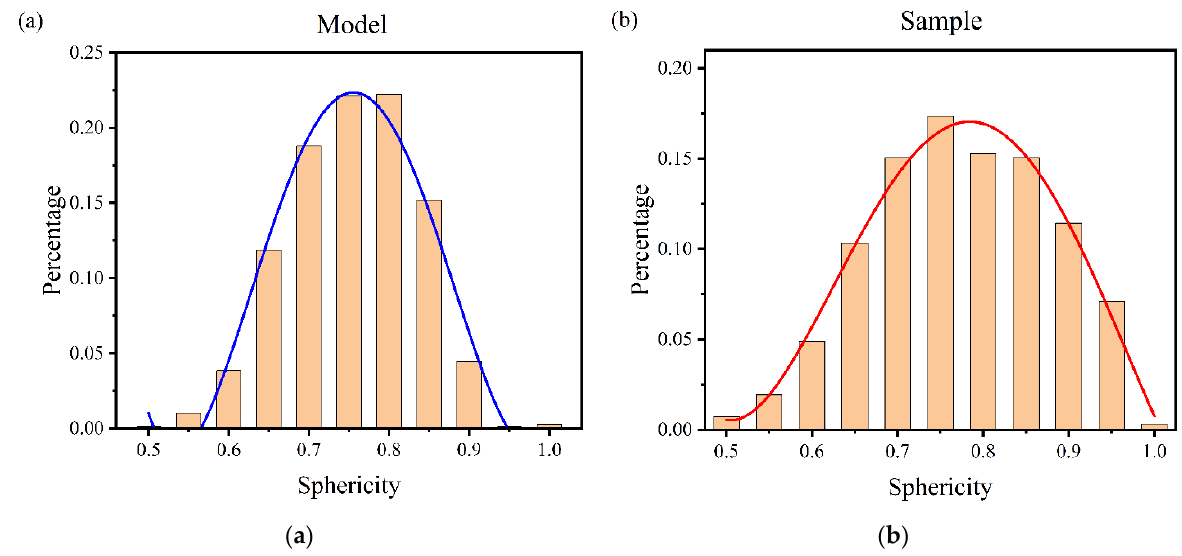
Figure 13. Sphericity vs. percentage of pores. ( a ) Percentage of the number of pores with different sphericity in the model of this paper; ( b ) Percentage of the number of pores with different sphericity in the sample.